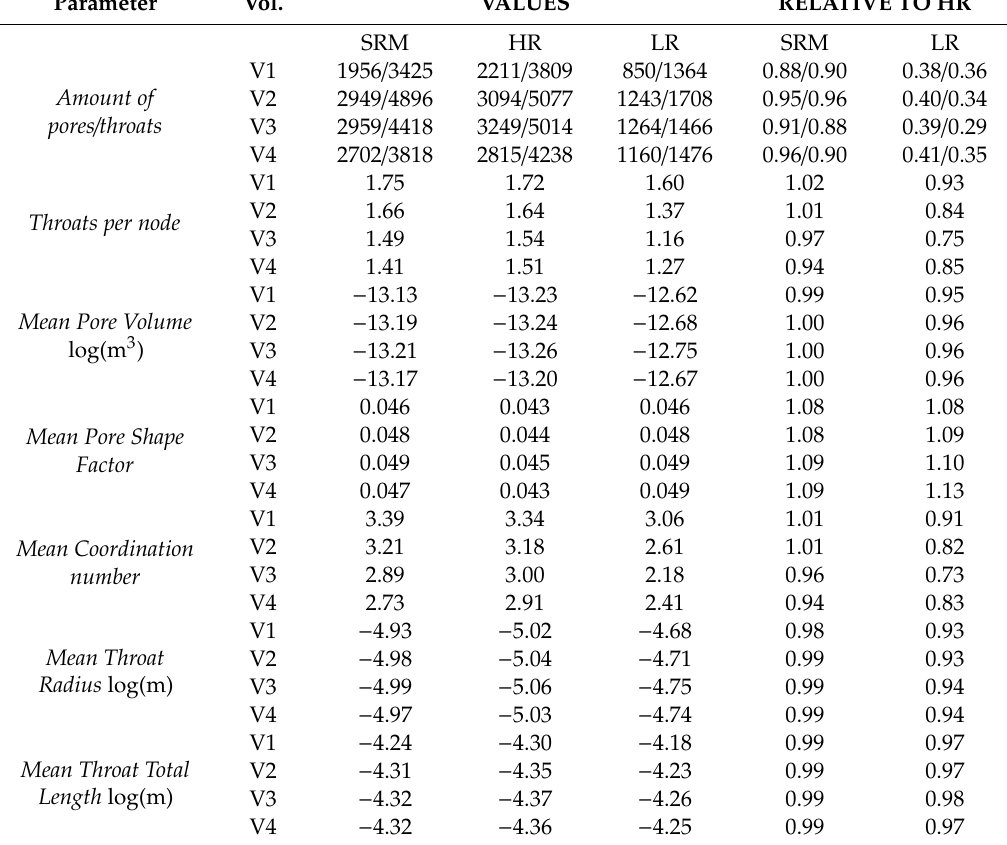
Table 3. Impact of super-resolution models on mean pore network properties, studied for four volumes of 500 3 voxels each (3 first columns). Relative di ff erence with expected high-resolution data (last 2 columns).